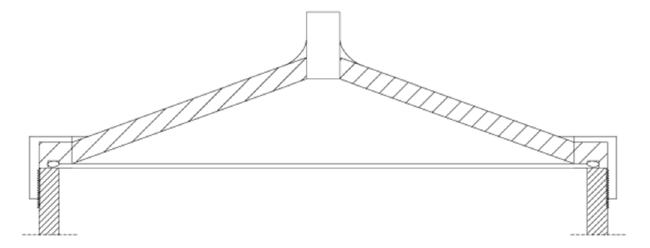
Figure 1. Diagram of the dilatometer cover.